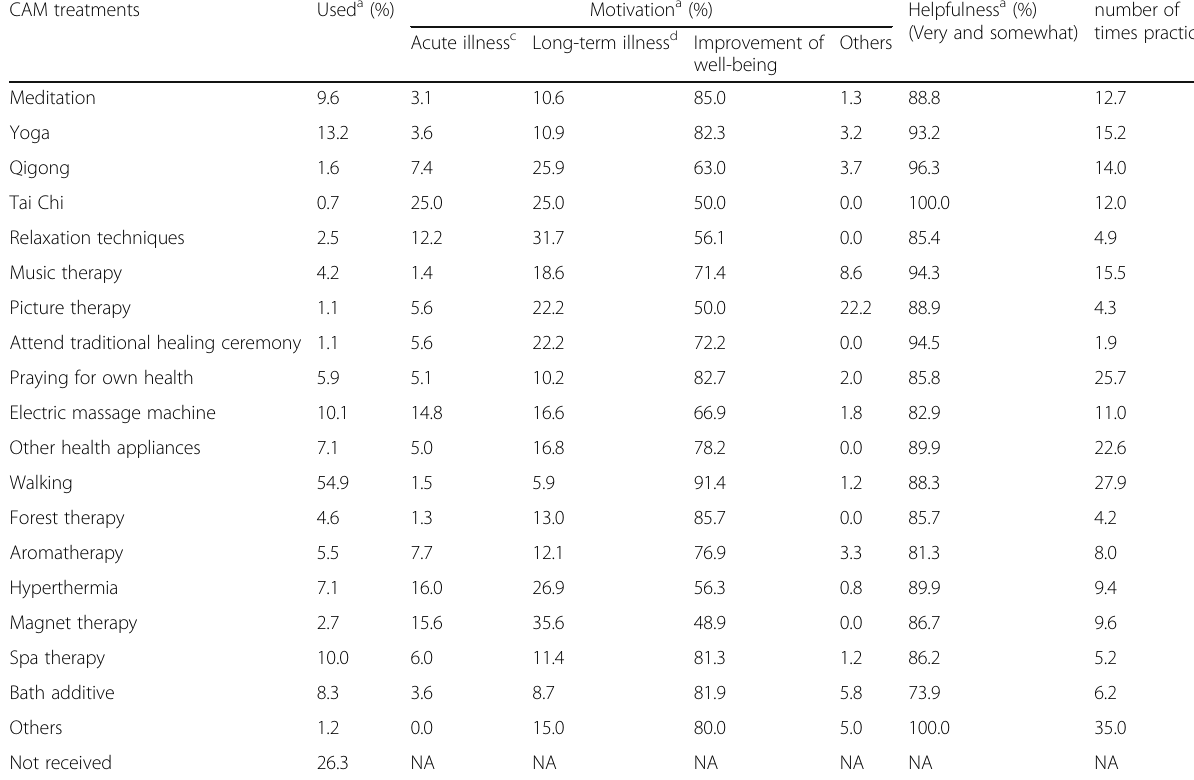
Table 5 Self-help practices CAM